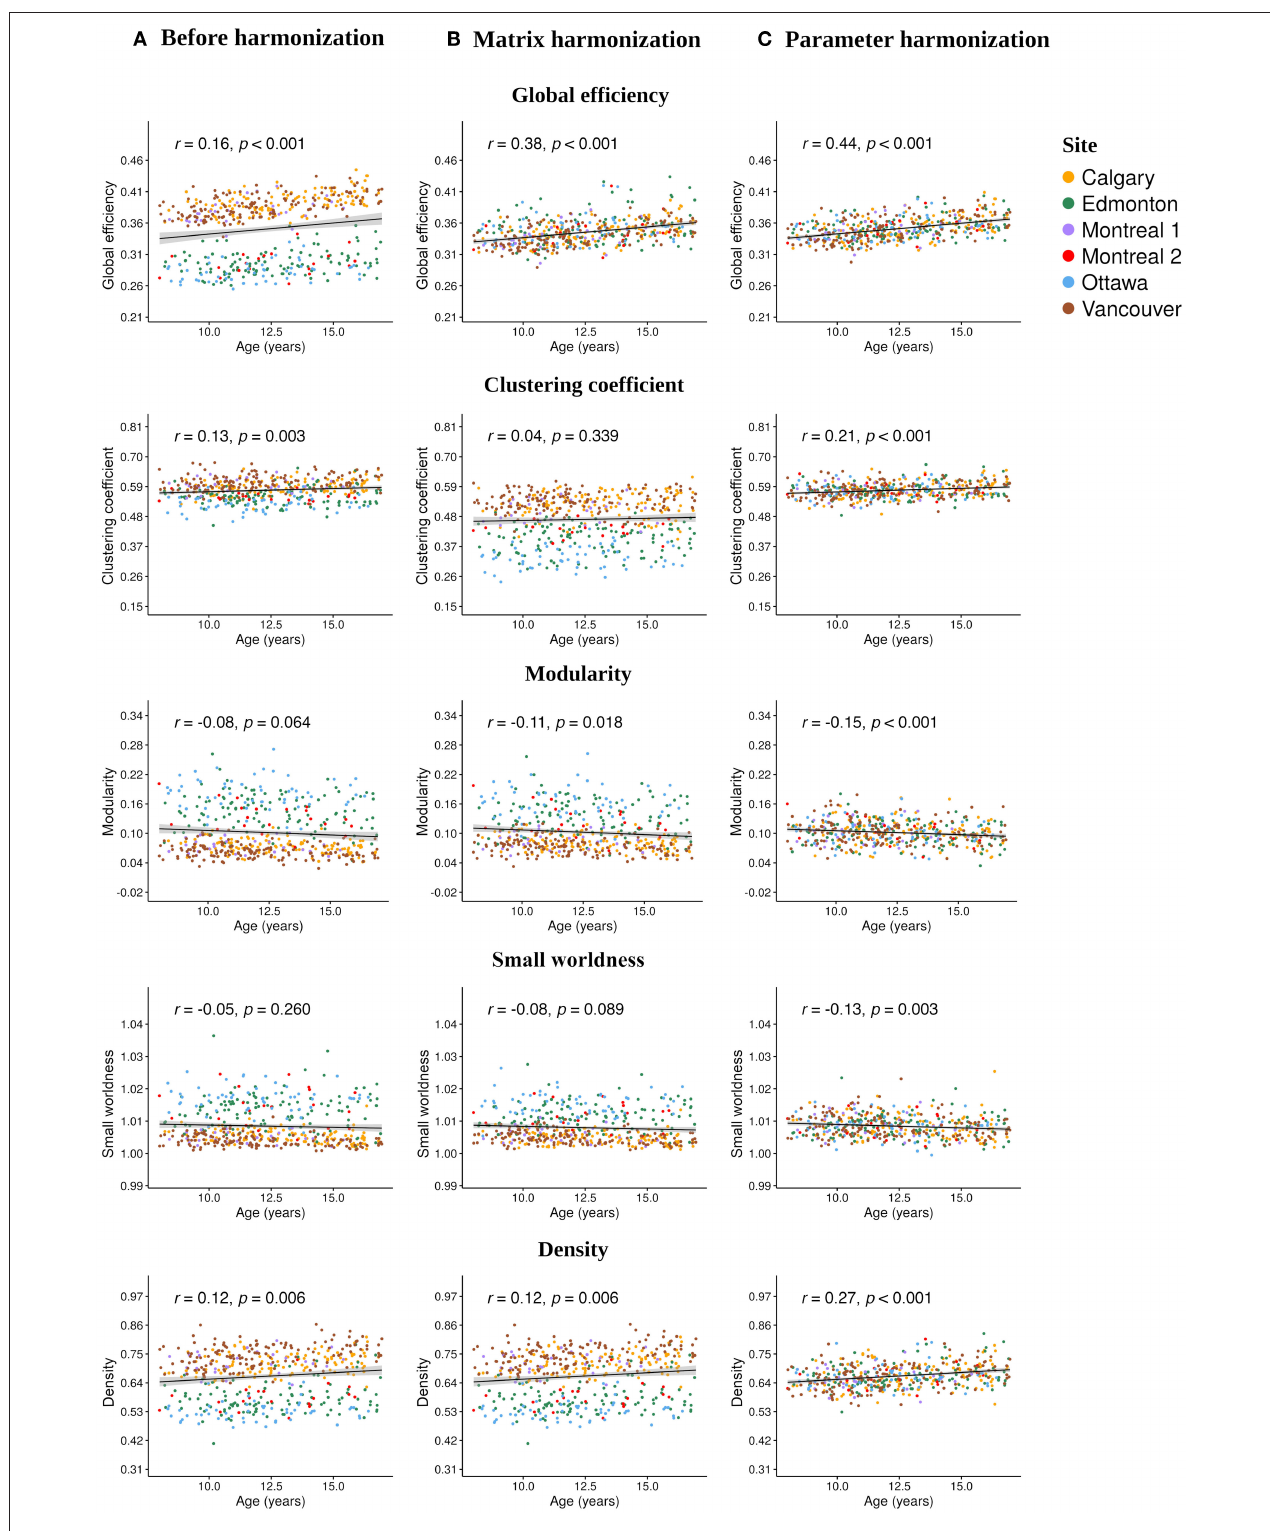
FIGURE 4 | Scatter plots illustrating the Pearson correlations between age at injury and each global network parameter calculated (A) before harmonization, after (B) matrix, and (C) parameter harmonization.